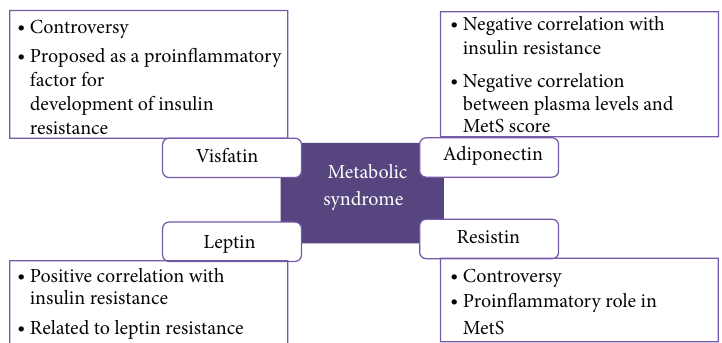
Figure 2: Schematic representation of adipokines actions in metabolic